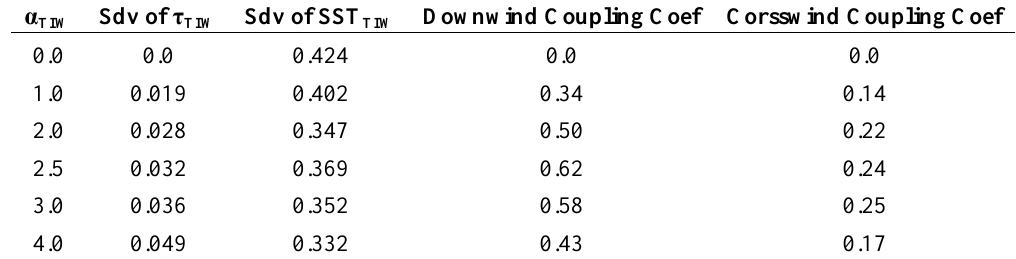
Table 1. The spatially averaged sdv for the zonal τ and SST fields in the region TIW TIW (0°N–5°N, 150°W–105°W), calculated using daily data in year 13. Also given are the binned slopes between the zonal-high-pass filtered wind stress divergence and the downwind component of the SST gradient (Downwind coupling coefficient), and between the zonal-high-pass filtered wind stress curl and the crosswind component of the SST gradient (Crosswind coupling coefficient), whose computations are made over the region (0°N–5°N, 150°W–105°W) during the cold season (August–December). Results are shown as a function of TIW wind feedback intensity, indicated by the rescaling factor, α , ranging from TIW α = 0.0 (no TIW wind) to α = 4.0 (a strong TIW wind case), respectively. The unit is TIW TIW dyn·cm −2 for τ , °C for SST , and is N·m −2 per 10 4 km for the coupling TIW TIW